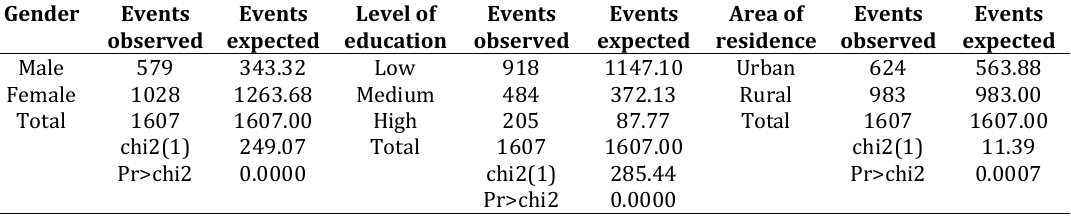
Table 12: Log-rank test for equality of survivor functions